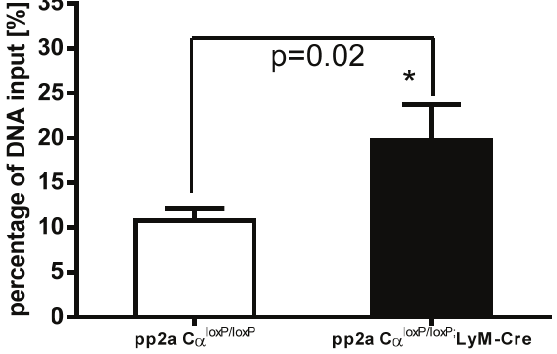
Figure 7. Epigenetic regulation of TNF-(cid:2) gene expression in tolerized control and PP2AC(cid:2) knockout macrophages. Elicited peritoneal macrophages were isolated from control PP2AC(cid:2) l ° x/l ° x mice and PP2AC(cid:2) l ° x/l ° x ;lyM-Cre mice. Both cells were pretreated with 100 ng/mL of LPS for 24 h and then washed and re-stimulated with second LPS (100 ng/mL) for 2 h. Chip-IP procedure was conducted as described in “Materials and Methods”. DNA samples subjected to immunoprecipitation were analyzed for the presence of TNF-(cid:2) promoter sequences in the DNA/protein complex by Q-PCR and obtained CT values were standardized with the CT values from non-immuoprecipitated input DNA. Data was expressed as percentage of input DNA: % (ChIP/Total input). In these tolerized cells, PP2AC(cid:2) knockout cells shows more binding of the epigenetic “on” signal (H3K4Me3) to the promoter region of TNF-(cid:2) gene as compared to control cells (* p <